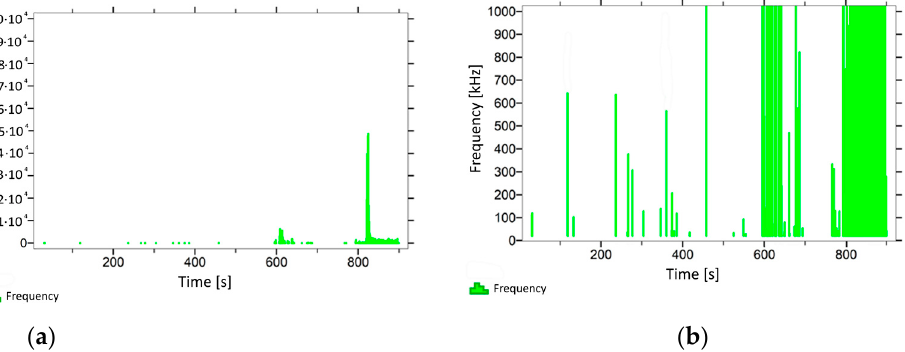
Figure 8. Graph of frequency distribution during the test for a representative sample from series P 7 : ( a ) considering the entire occurring frequency range and ( b ) with details about the frequency range before the moment of breakage.